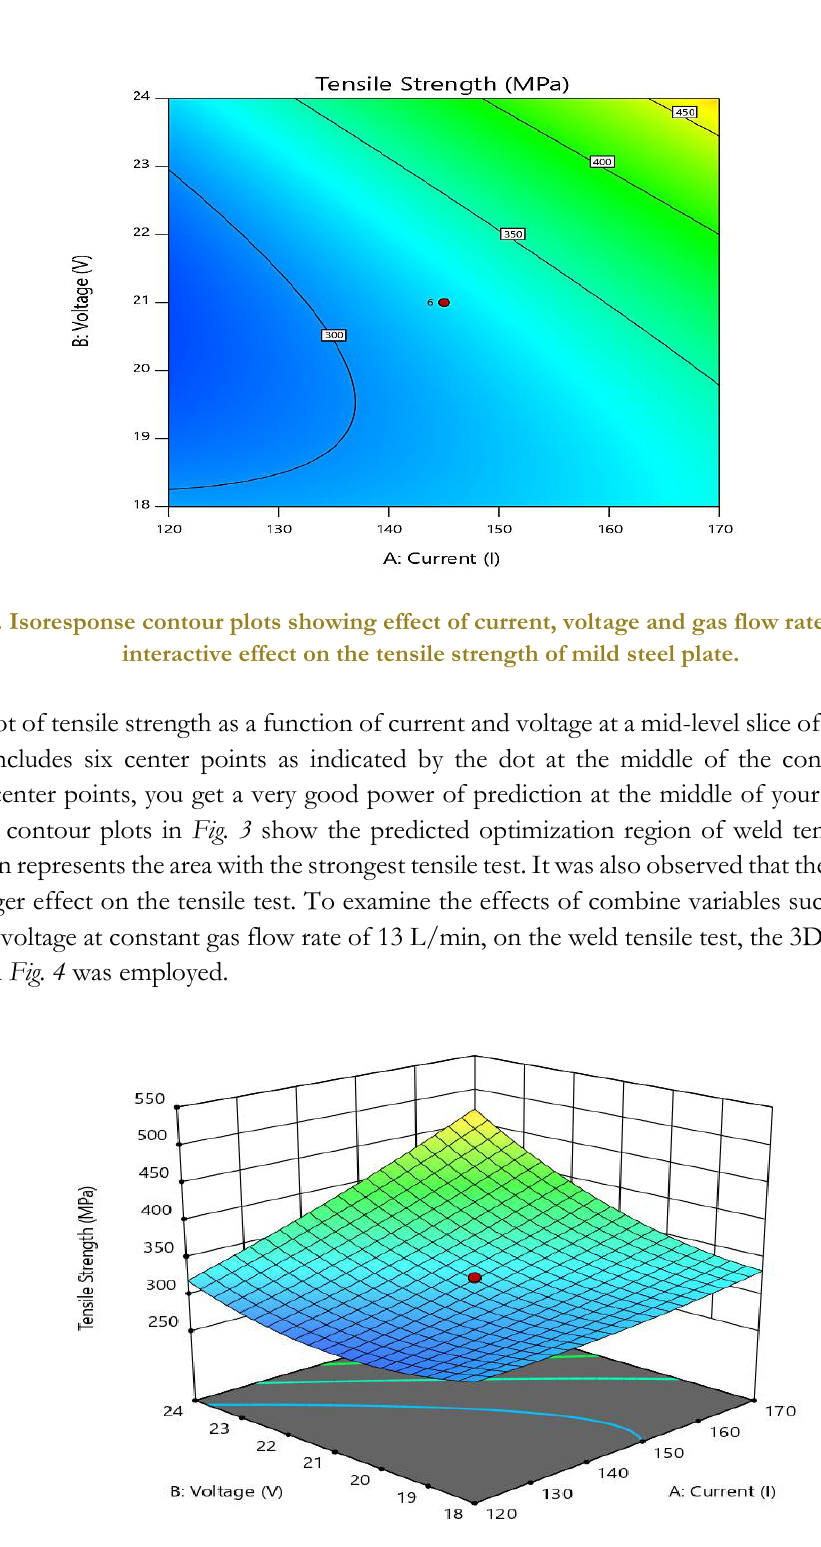
Fig. 4. Response surface plots showing effect of current, voltage and gas flow rate and their interactive effect on the tensile strength of mild steel